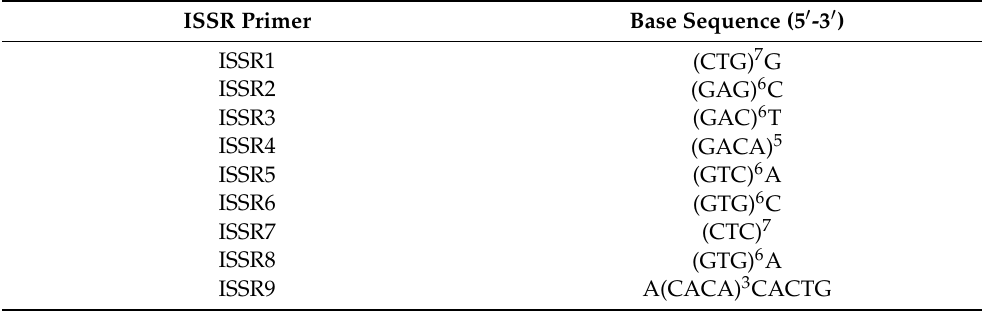
Figure 6. ISSR analysis of mother plant and in vitro regenerated plants of L. chinense. M- 1 kb DNA ladder, 1- mother plant, 2–13 in vitro regenerated plants. Amplification products obtained with inter simple sequence repeats primer (ISSR) using ISSR4 primer. Table 7. Inter simple sequence repeat (ISSR) marker used for assessment of the genetic stability in regenerated shoots of L.